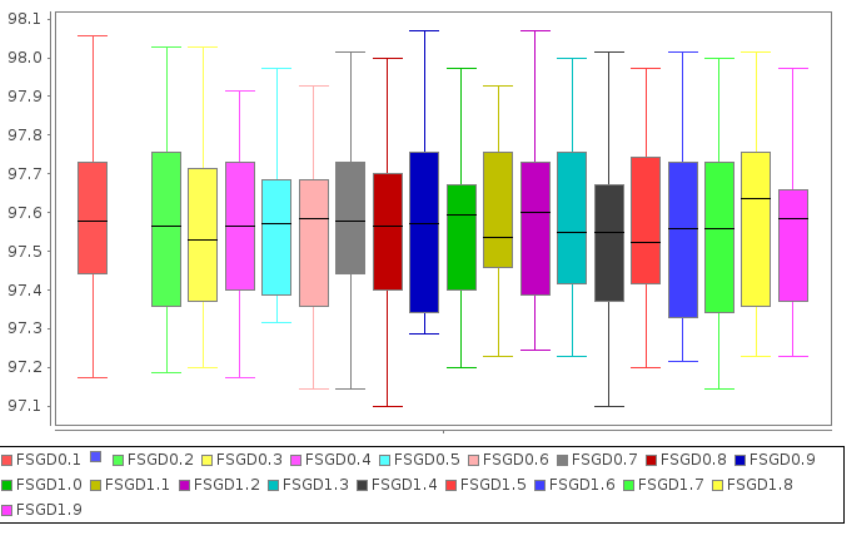
Figure 3. Accuracy boxplots for FSGD with 10-cross folding, momentum = 0.9 and ν = 0.1,0.2, . . . ,1.9. Table 4. Comparison between SGD and FSGD with momentum. The case ν = 1.0 reduces to SGD.